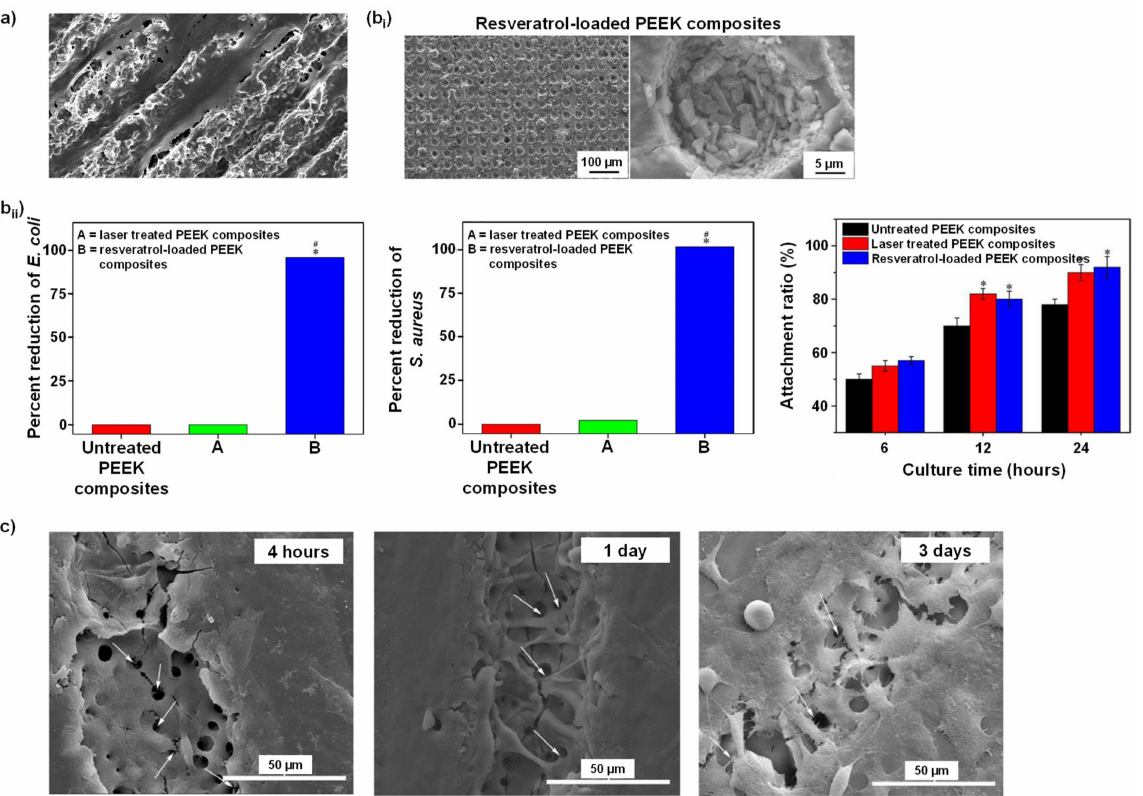
Figure 11. Laser treatment of PEEK surfaces. ( a ) Gheisarifar et al. observed cell alignment and elongation following the geometry of the surface topography (grooves) [40]. ( b ) The work from Cai et al.: ( b i ) SEM images showed porous PEEK composites loaded with antibacterial agent resver- atrol; ( b ii ) antibacterial activity (* p < 0.05 against untreated PEEK, # p < 0.05 against laser treated PEEK) and cell attachment ratio (* p < 0.05 against untreated PEEK), respectively [205]. ( c ) SEM images showed the morphology of MC3T3-E1 pre-osteoblasts cultured for 4 h, 1 d, and 3 d. White arrows : cell pseudopodia protruding into the laser-generated pores [206]. All figures were re-printed with permission from the literature